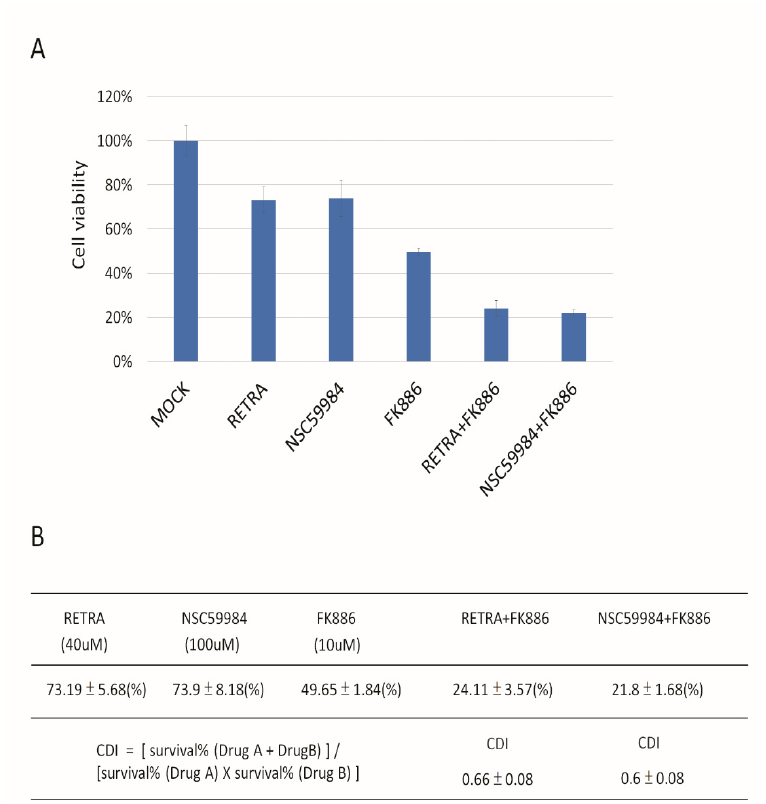
Figure 7. NAMPT inhibitor was able to repress protein aggregation signals. Although all the inhibitors tested (NAMPT, SIRT1 and HSP70) reduced the aggregation signals in Detroit 562, the NAMPT inhibitor had the most pronounced effect in reducing the protein aggregation. The protein aggregation signal was calculated as the OD ratio of ThT/Hoechst 33342 as normalized ThT fluorescence intensity. Mock was calculated as 1 to normalize for other conditions.